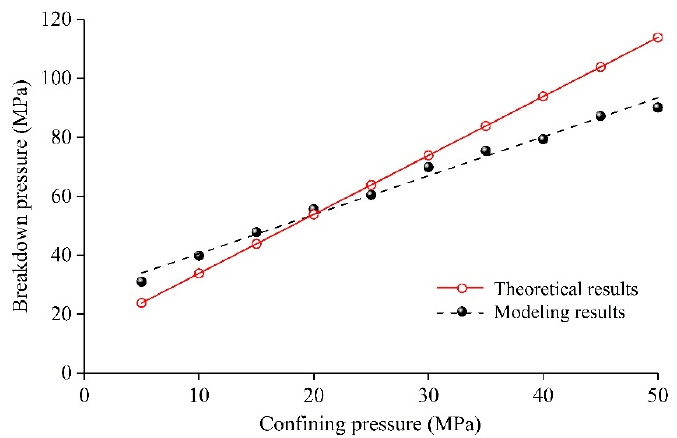
Figure 6. Comparison of breakdown pressures between the simulated values and the analytical